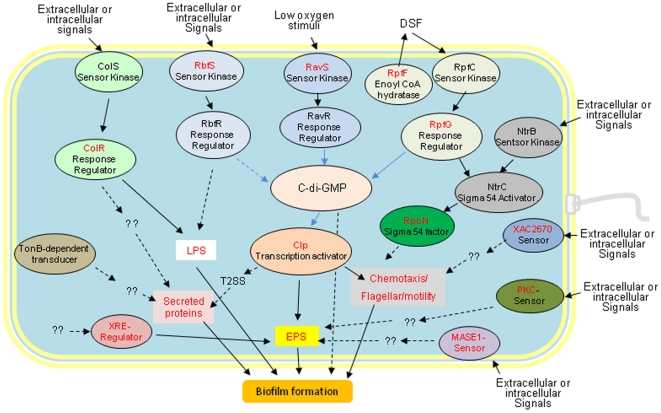
A schematic illustration of the global regulation in biofilm formation by X. axonopodis pv. citri (Xac).The principle pathways are presented, including experimentally determined systems and other members that were not discussed in detail here. The global regulator in Xac is the cyclic di-GMP second messenger. Cyclic di-GMP is degraded by the HD-GYP or EAL domain-containing proteins via RpfC/RpfG, RavS/RavR, and RbfS/RbfR TCSTSs; by cell-to-cell communication; and/or other methods. Cyclic di-GMP levels affect the activity of the Clp transcriptional activator and subsequently affect EPS, cell motility, extracellular proteins/enzymes, and final biofilm formation. Genes identified in this study are presented in red, while genes that were previously reported in xanthomonads are presented in black. Black arrows indicate positive regulation, and blue arrows indicate negative regulation. A dotted line suggests a hypothesized connection that needs to be probed by further experimentation.